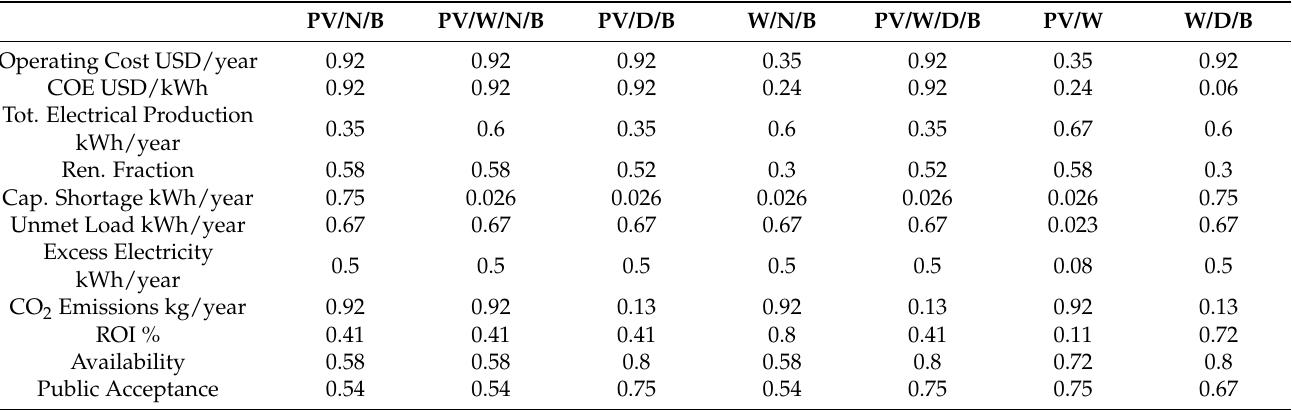
Table 7. Normalised decision matrix.